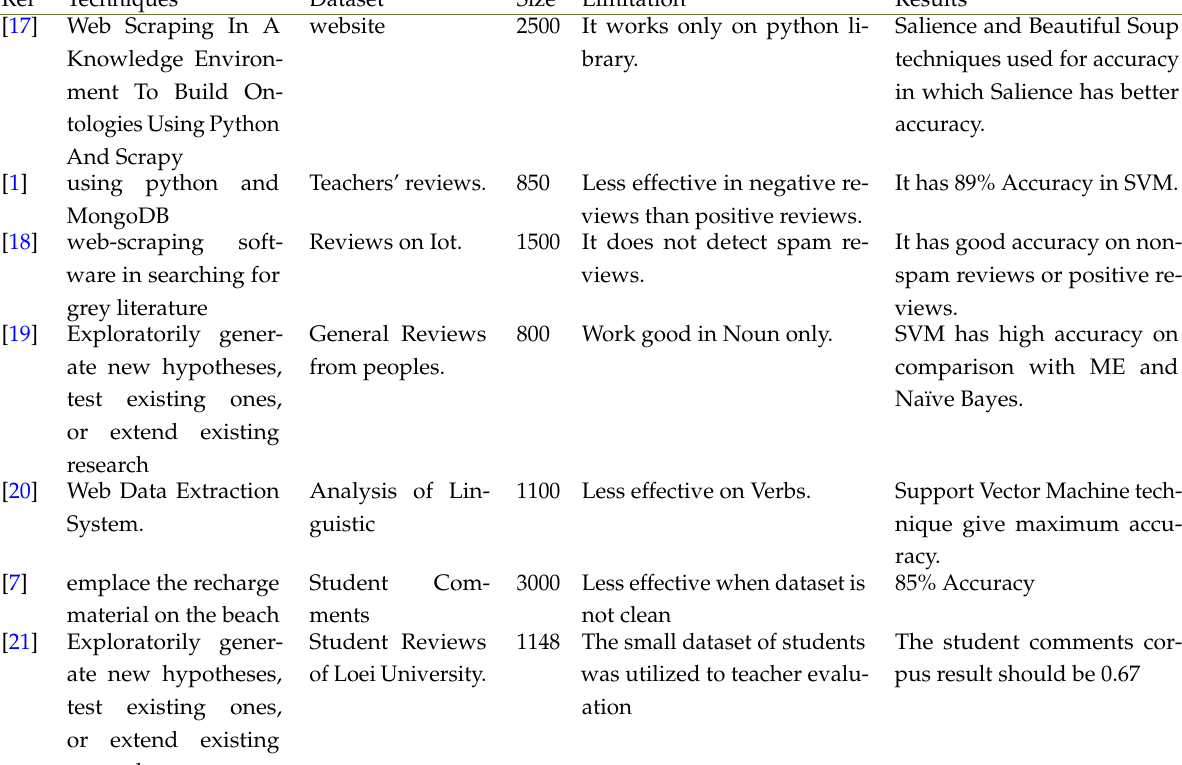
Table 1. Comparison of scraping tool previous